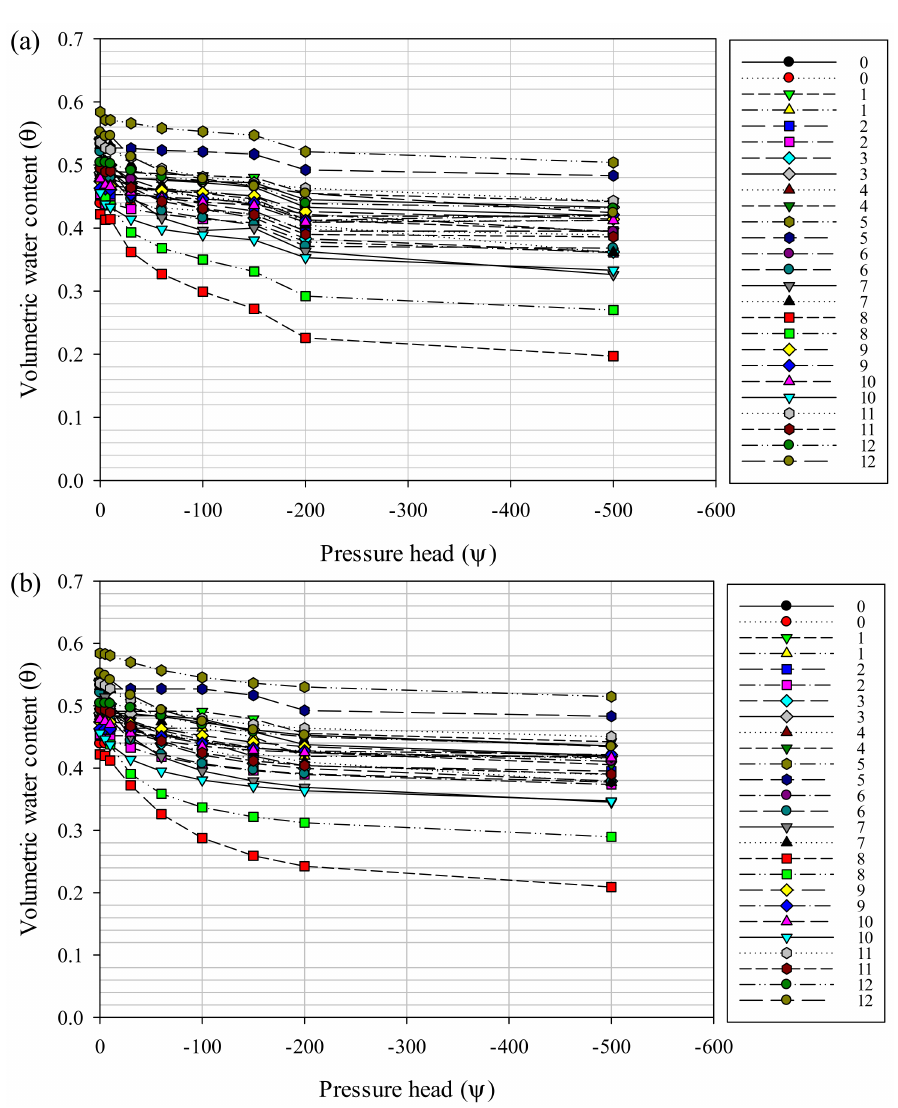
Figure 5. Water retention θ ( ψ ) curves for a skidder track area 0–12 years after IFMS treatment. ( a ) Observed θ ( ψ ). ( b ) Estimated θ ( ψ